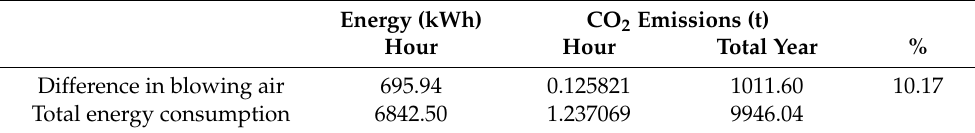
Table 2. Emissions